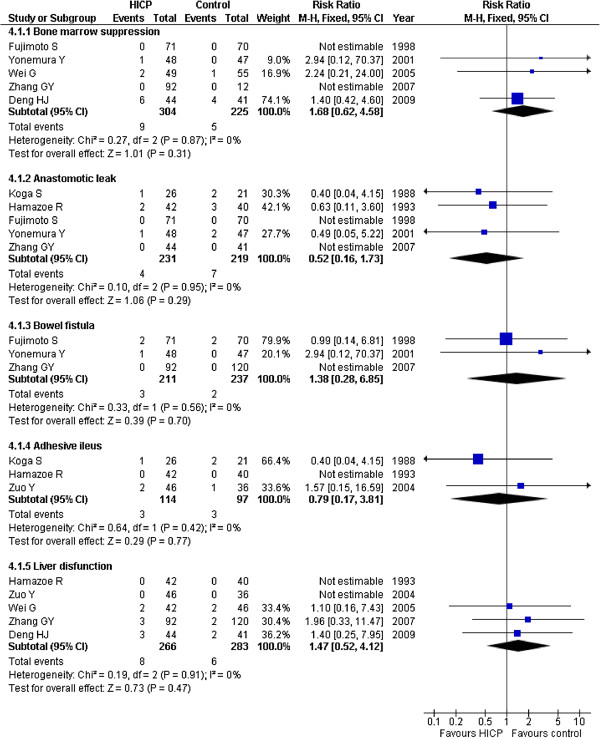
Risk Ratios for adverse events.